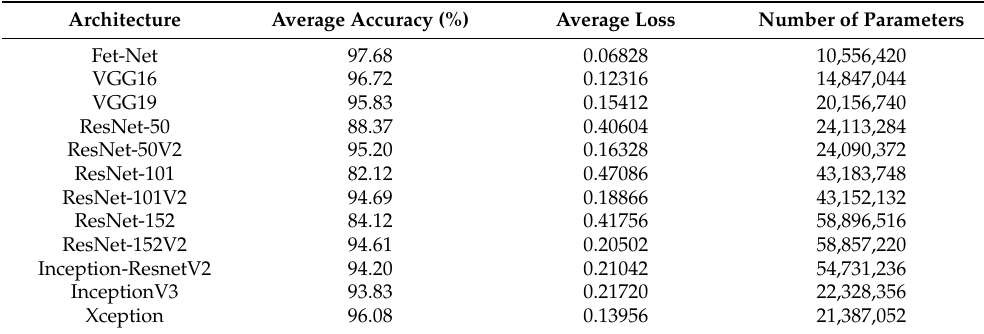
Table 2. Summary of performance metrics for Fet-Net and prominent CNN architectures during the 5-fold cross-validation